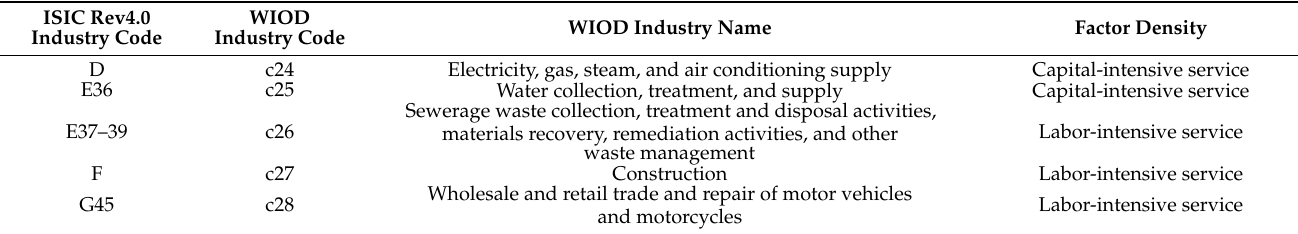
Table 1. Industry classification of WIOD